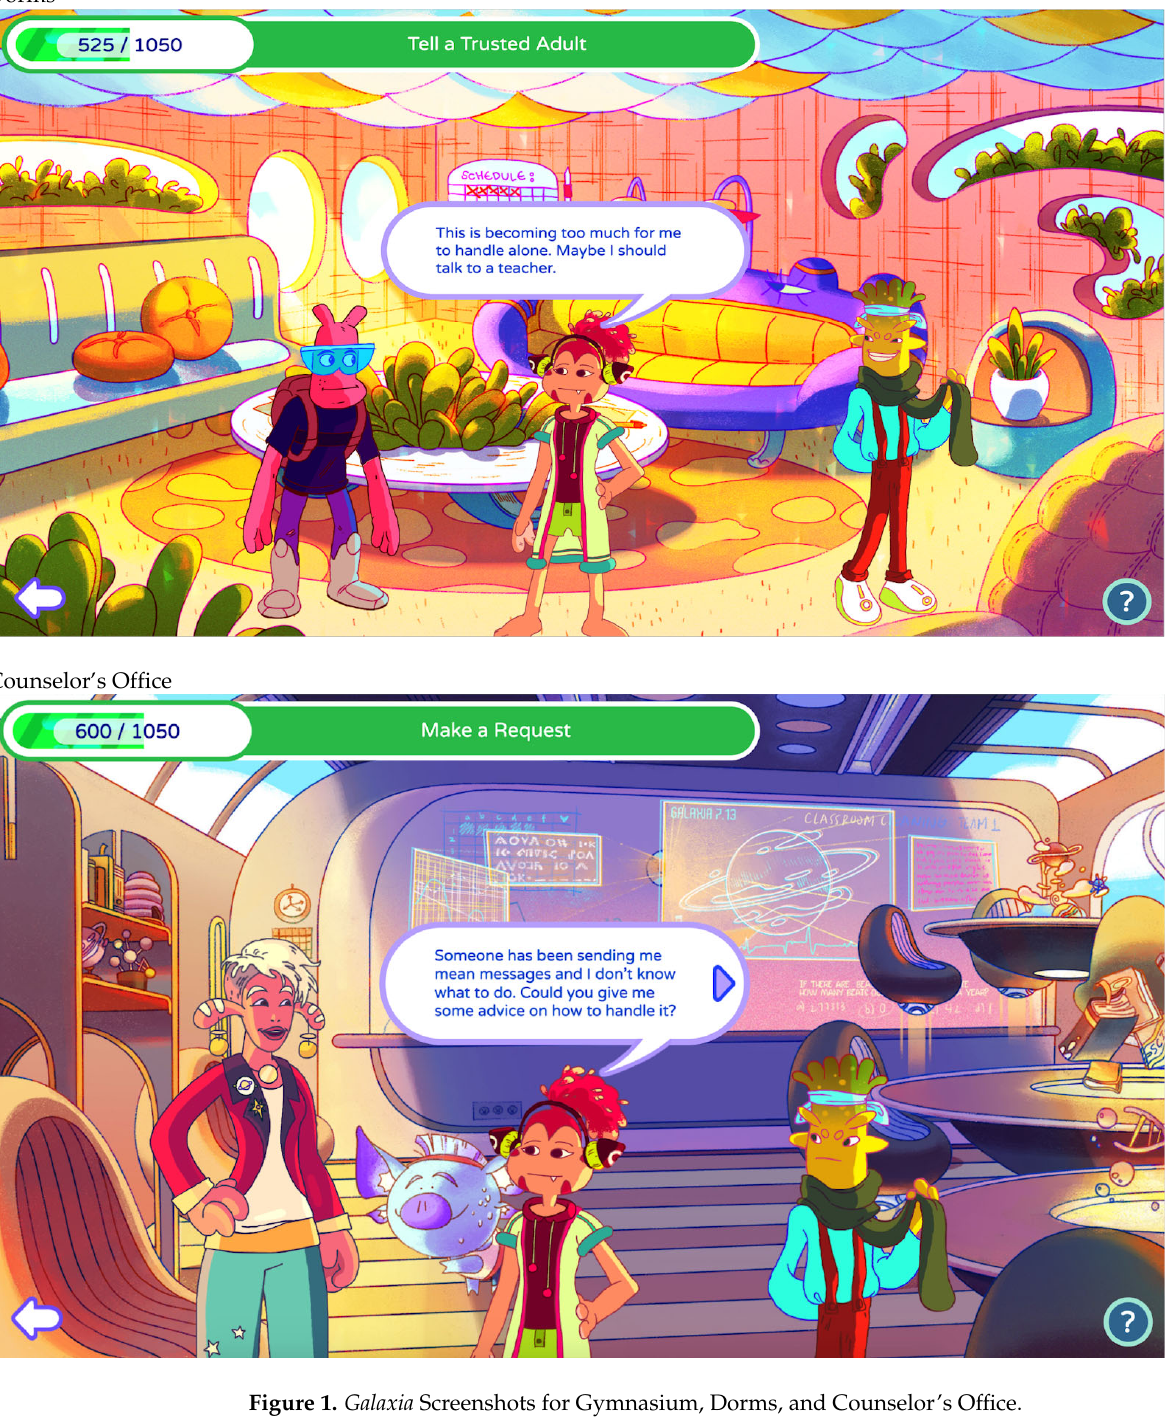
Figure 1. Galaxia Screenshots for Gymnasium, Dorms, and Counselor’s Office.